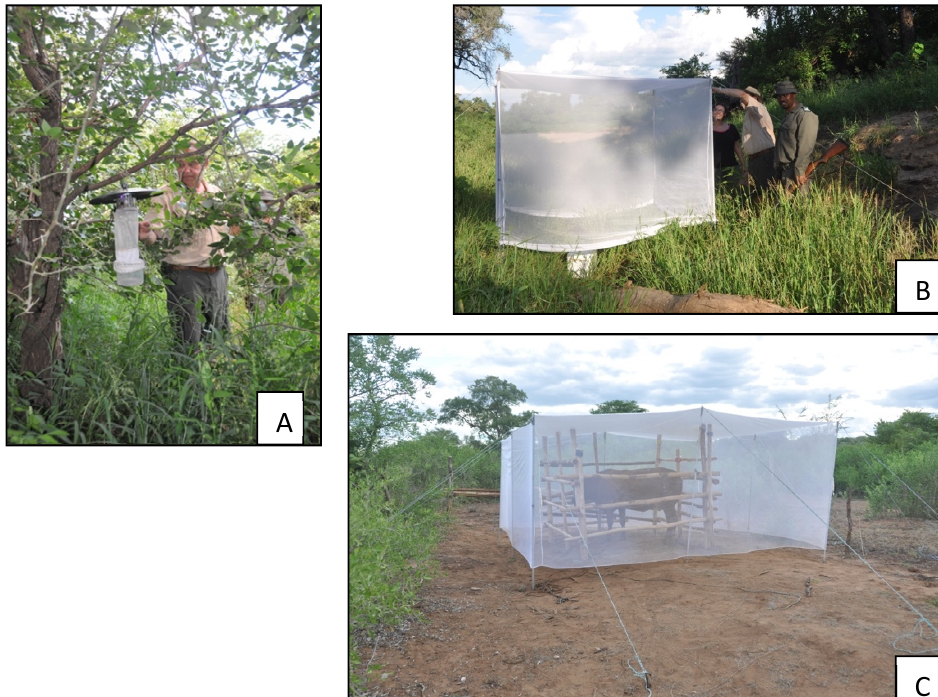
Figure 2. Trap types deployed during current study: ( A )—CO 2 -baited CDC light trap; ( B )—CO 2 -baited tent trap; ( C )—cow-baited tent trap.